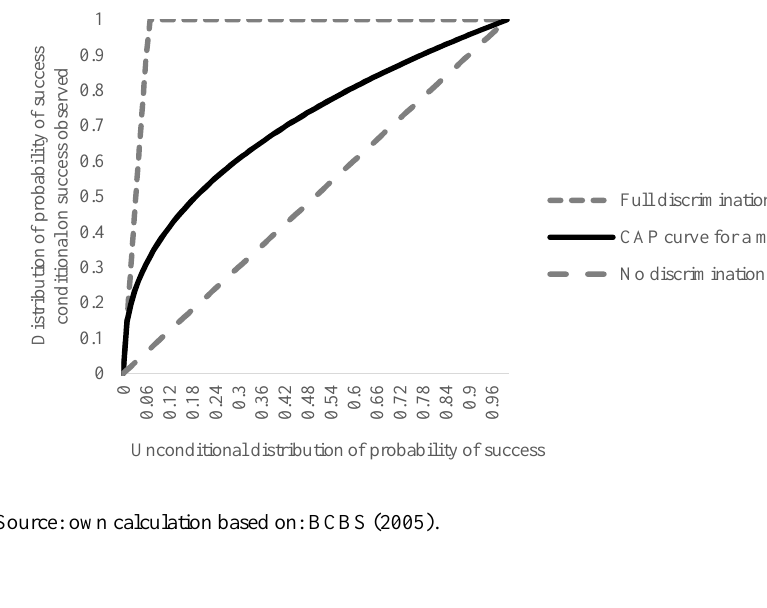
Figure 1. Example of CAP curve